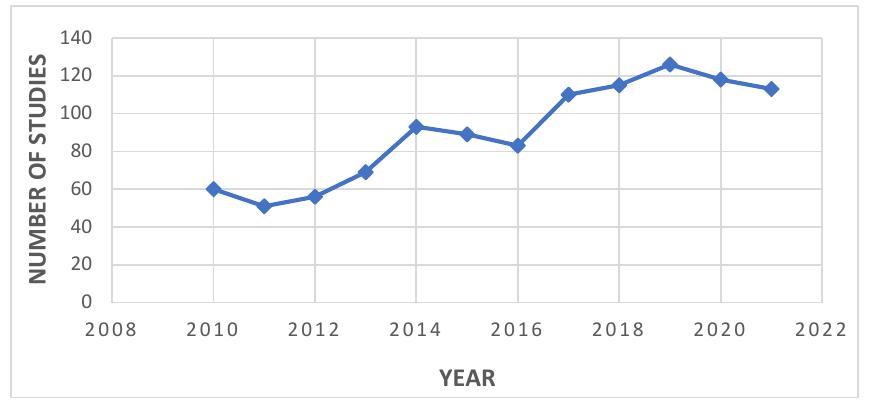
Figure 2. Schematic representation of research interest toward small molecule inhibitors in liver cancer treatment. Y -axis represents number of studies and X -axis represent years. These data were collected from